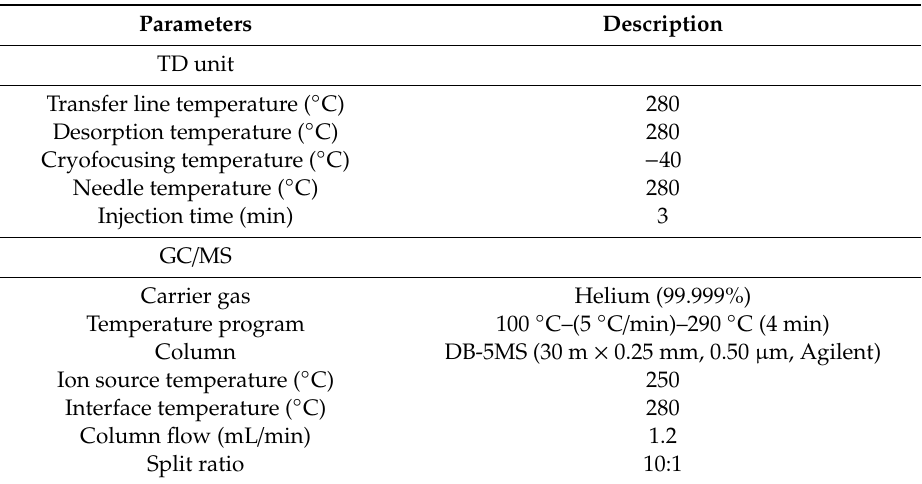
Table 2. Parameters of thermal desorption (TD) unit and gas chromatograph / mass spectrometer (GC / MS). Parameters